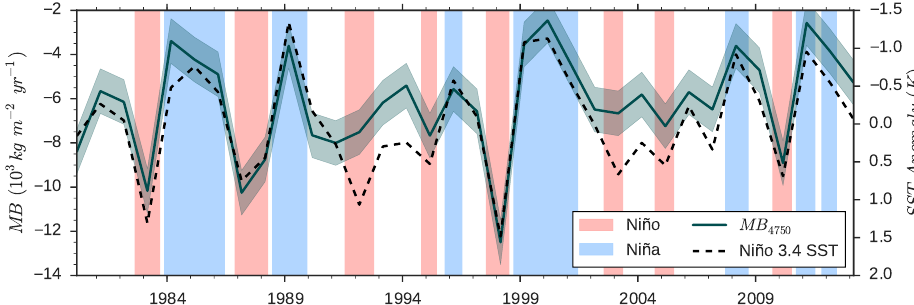
Figure 8. Annual average of the computed MB 4750 and of Niño 3.4 SSTA shifted forward by 3 months (note the inverted right y axis). The shading represents ± RMSE (including the error of both the downscaling and the reference data